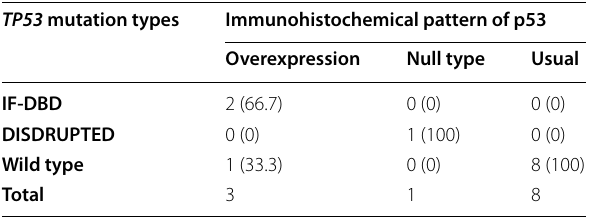
Table 6 Immunohistochemical staining patterns according to the TP53 mutation types in MDM2 ‑amplified